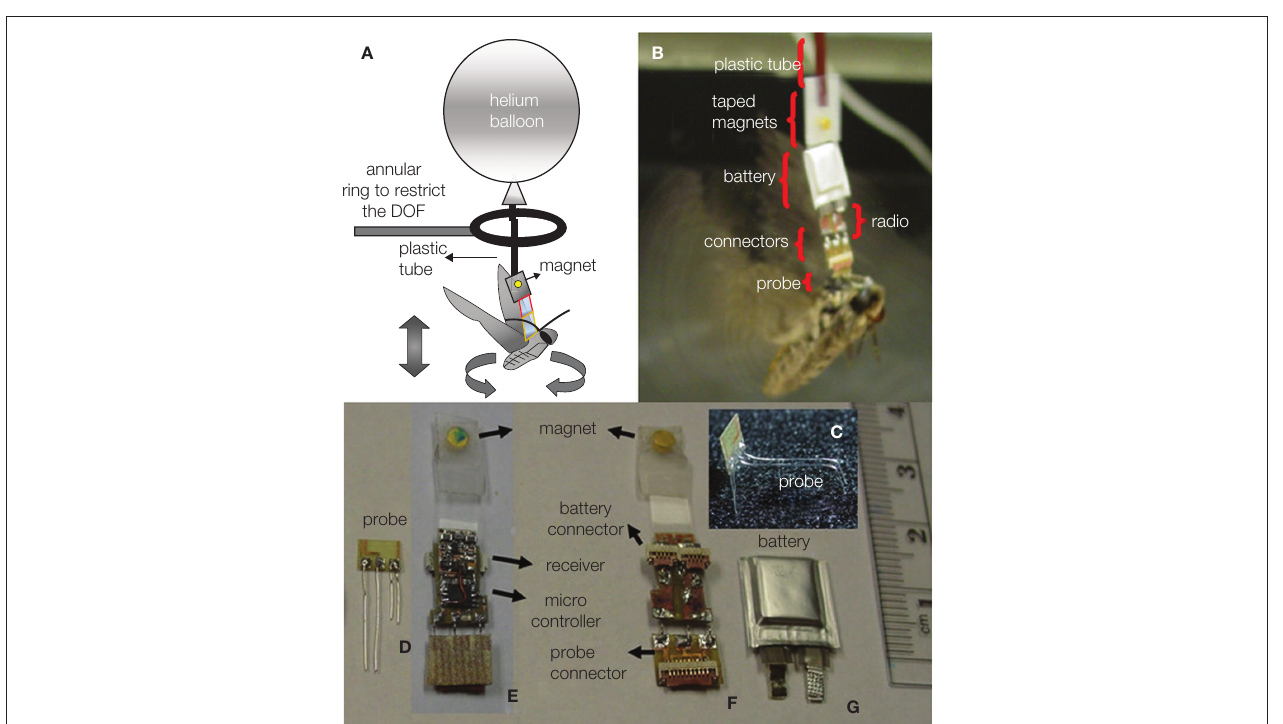
rechargeable battery included). (C–e) anatomical pictures of (C,D) muscular stimulation site (right basilar muscle), (e) optic lobe and brain stimulation sites (the fat bodies, tracheae were removed to provide the clear images). The blue bar and letters of X indicate the electrode inserted length and positions, respectively.